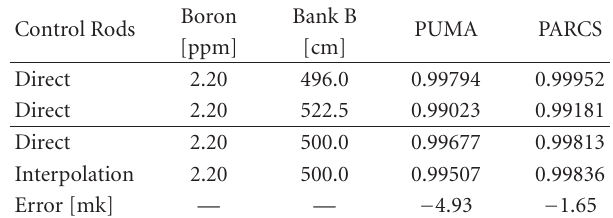
Table 12: CNA-I cold criticality—control